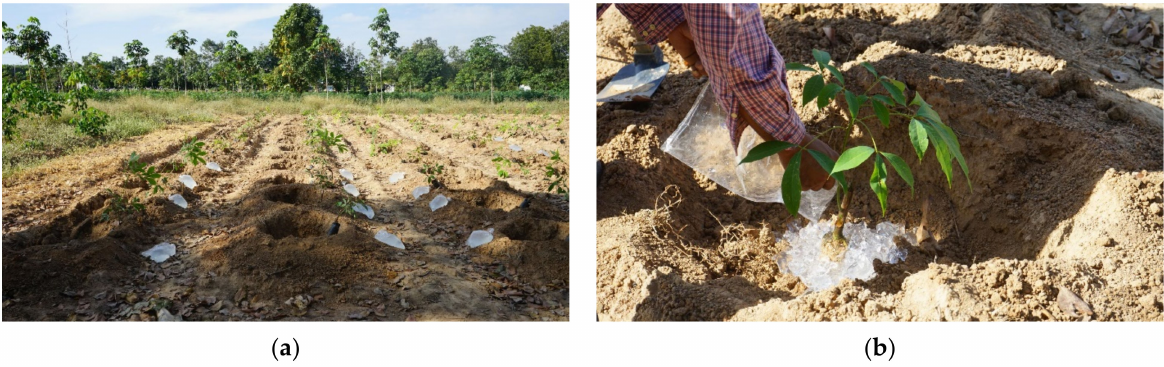
Figure 1. ( a ) Experimental field; ( b ) swollen super water absorbent (SWA) placed under and around the roots of young rubber